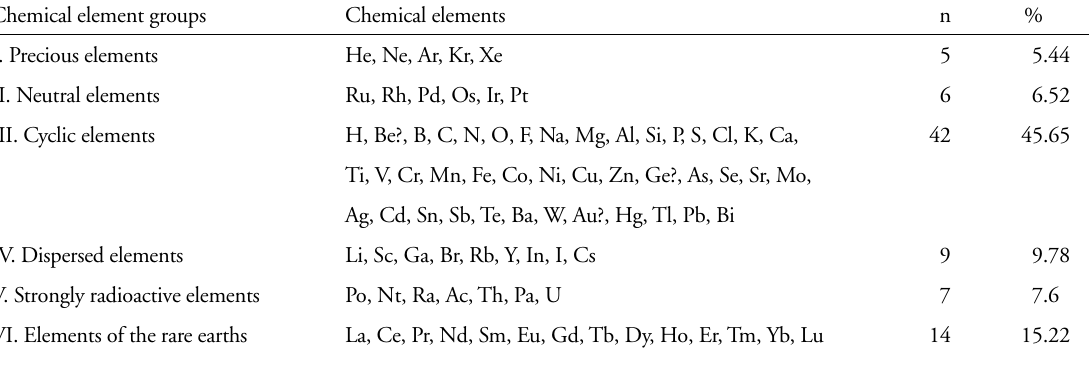
Chemical element